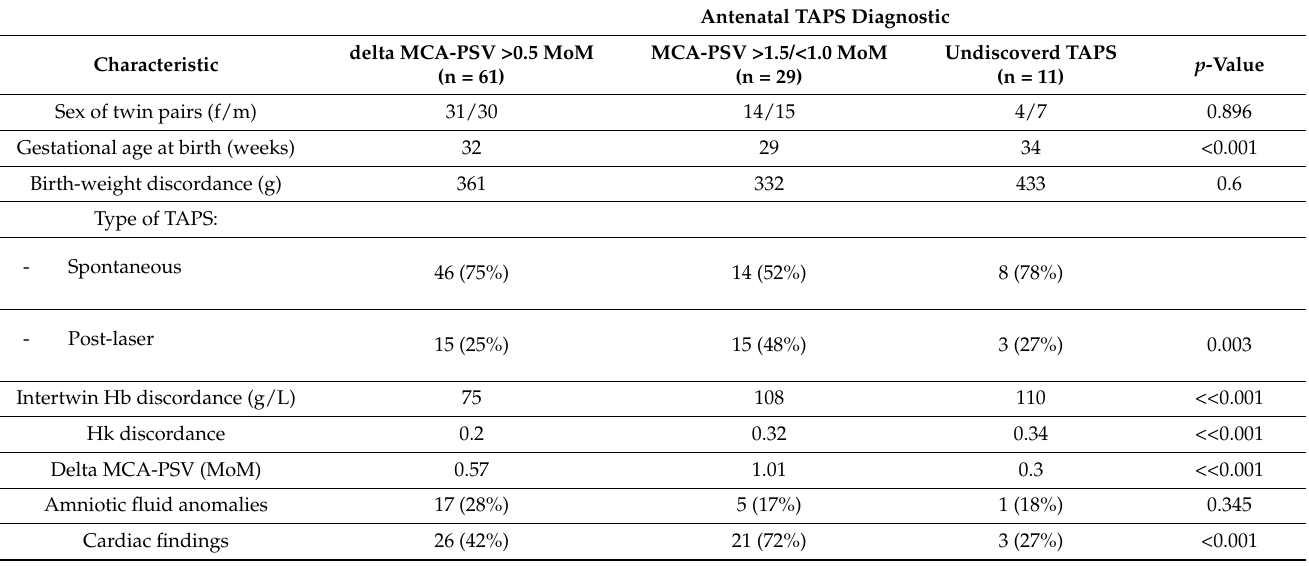
Table 3. Presentation of various fetal and neonatal characteristics in TAPS twins in relation to the dif- ferent diagnostic criteria (delta MCA-PSV > 0.5 MoM, MCA-PSV >1.5/<1.0 MoM, and